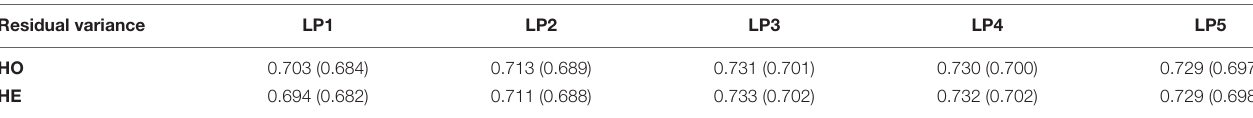
TABLE 5 | Pearson correlations (Spearman’s rank correlations) between EBV of 305-day milk yield obtained from full and reduced data for models with different orders of LP and with homogeneous (HO) or heterogeneous (HE) residual variance. Residual